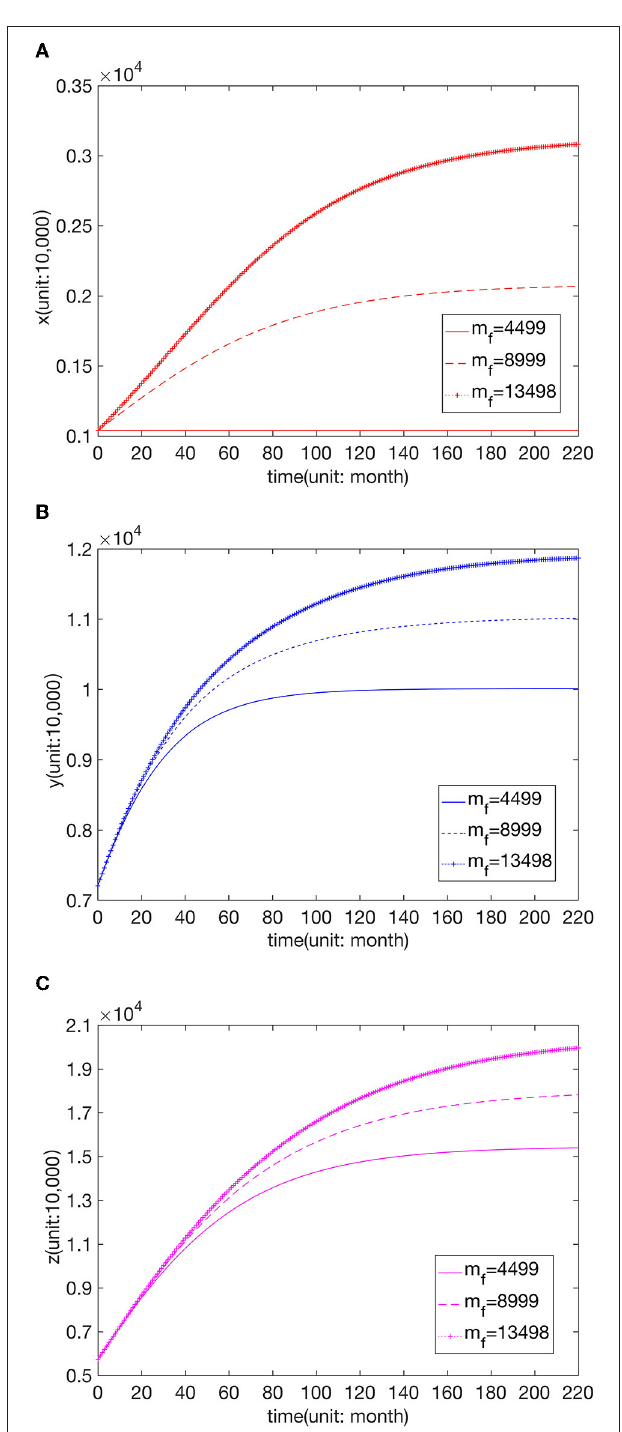
FIGURE 5 | Effect of parameter value η on the number of visits to (A) FLHs, (B) SLHs, and (C) TLHs.